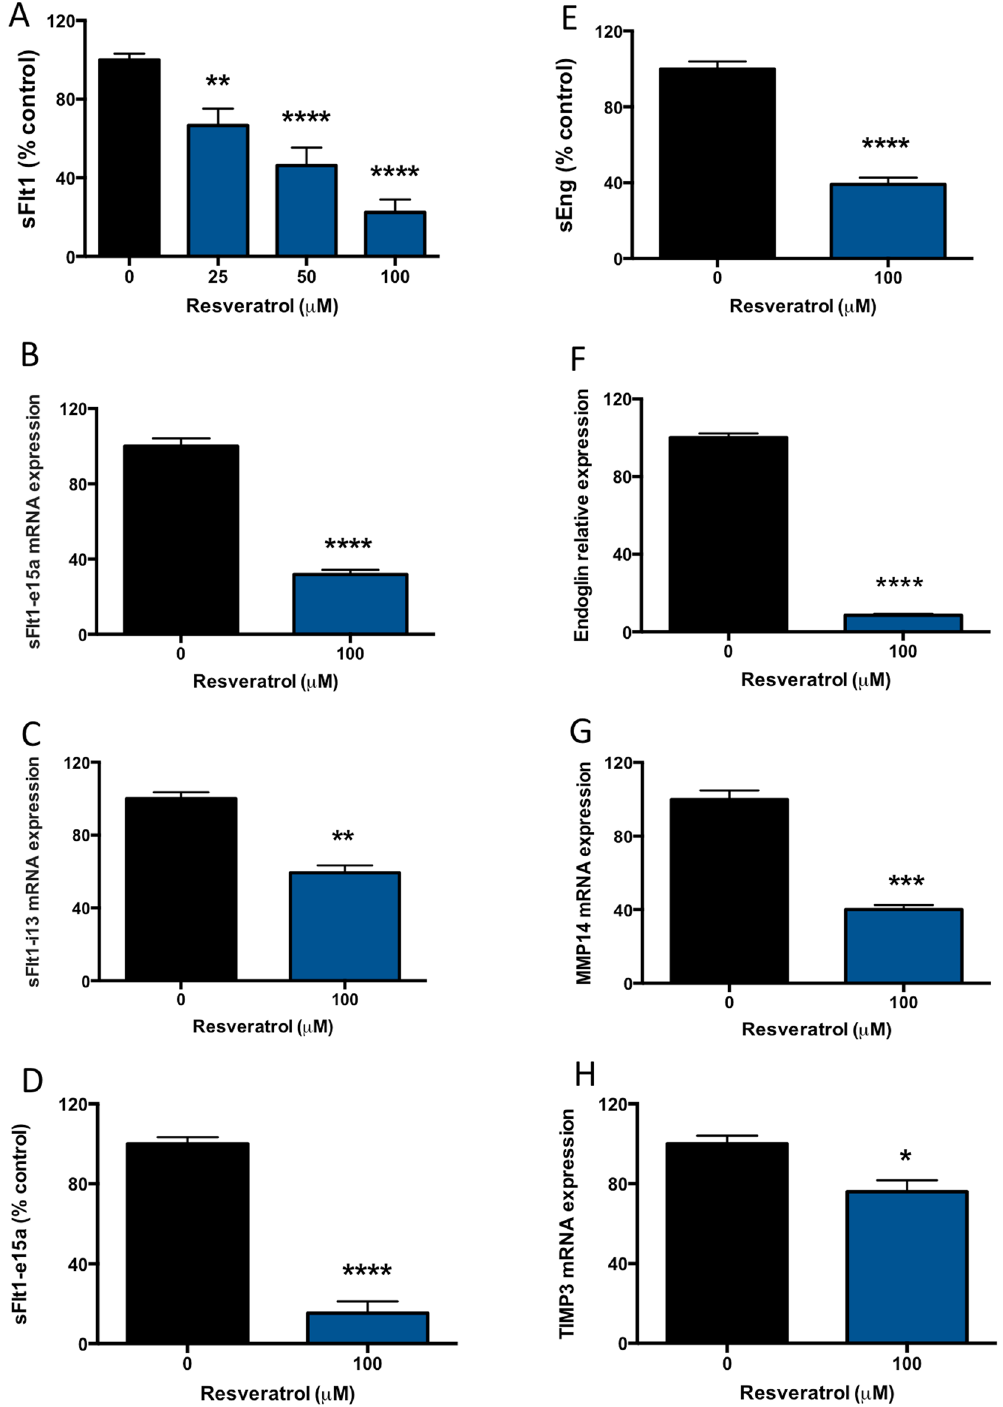
Figure 1. Resveratrol significantly reduces sFlt-1, sFlt-1 e15a and sEng secretion from primary cytotrophoblast. Resveratrol was added at increasing doses to primary trophoblast and the effect on sFlt-1 and sEng secretion determined. ( A ) Resveratrol induced a significant reduction in sFlt-1 secretion at 25–100 μ M. This was accompanied by a ( B ) significant reduction in the sFlt-1 placental variant, sFlt-1 e15a mRNA expression and a ( C ) significant reduction in sFlt-1 i13 mRNA expression. Given the marked effect on sFlt-1 e15a mRNA expression, we subsequently measured secretion of sFlt-1 e15a using our in-house ELISA and found that resveratrol potently reduced sFlt-1 e15a secretion ( D ). sEng is the other important anti-angiogenic factor associated with preeclampsia. ( E ) Resveratrol significantly reduced sEng secretion from primary trophoblast. This was accompanied by significantly reduced endoglin ( F ), MMP14 ( G ) and TIMP3 ( H ) mRNA expression. Data expressed as mean ± SEM. * p < 0.05 ** p < 0.01, *** p < 0.001, **** p < 0.0001 compared to 0 resveratrol. N = 3–5 experimental replicates, with each n taken from a separate patient